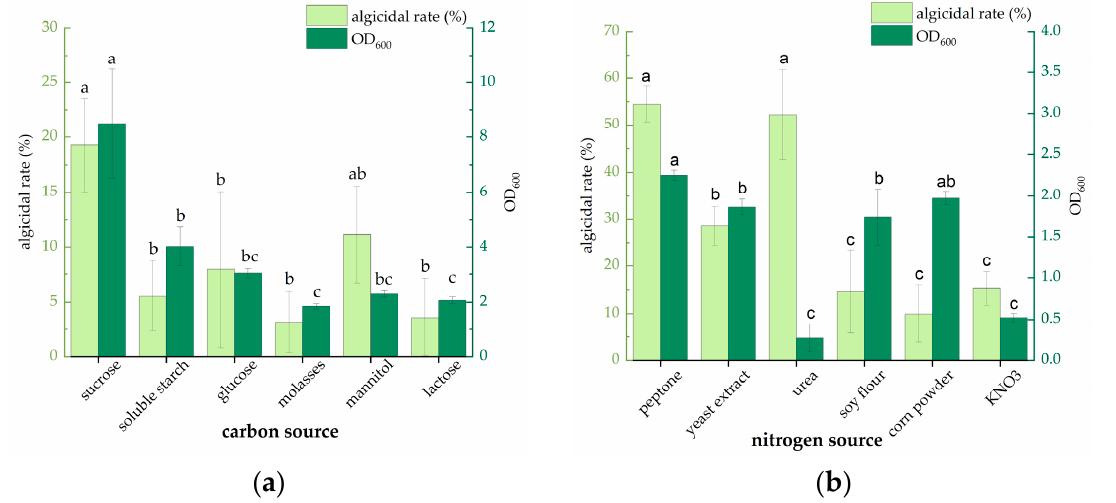
Figure 1. The effects of different carbon sources ( a ) and nitrogen sources ( b ) on the growth and algicidal activity of Alteromonas sp. FDHY-03. Error bars represent the standard deviation of the triplicates. The average of each group is ordered from largest to smallest to derive a, b, c. None of the same letters represent significant difference in each group ( p < 0.05); each group with the same letters is not significant.